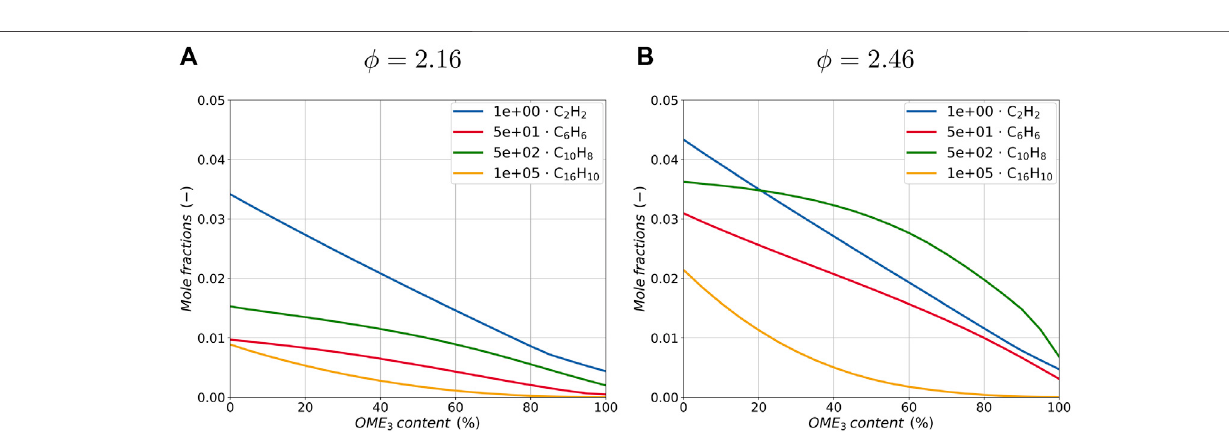
Frontiers in Mechanical Engineering |